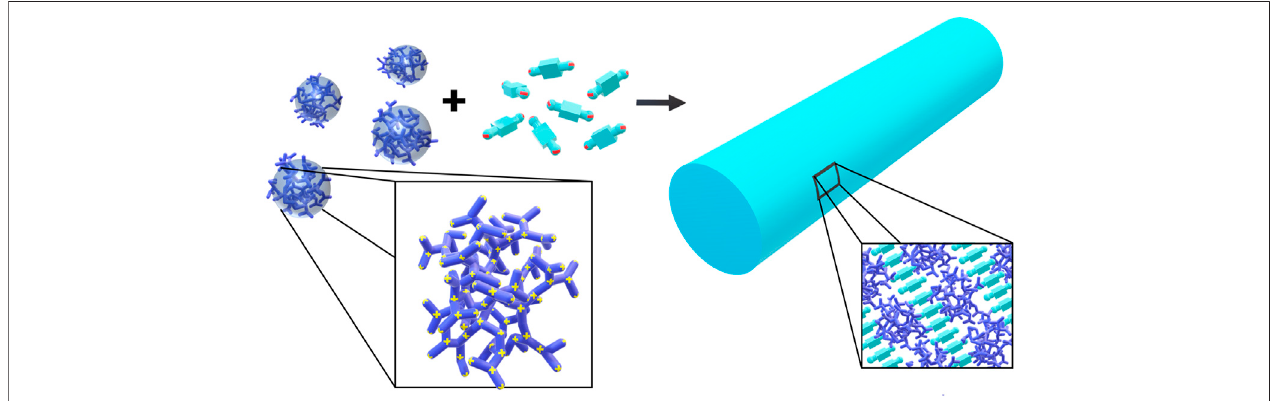
FIGURE 5 | Electrostatic self-assembly in solution: polyelectrolytes interact with oppositely charged stiff, multivalent counterions to form nano-objects with a de fi ned size and shape; for example, cationic 5 nm-sized G4 PAMAM dendrimers interacts with dianionic dye molecules to form a 100 nm scale elongated rod-like stricture with layered internal structure.